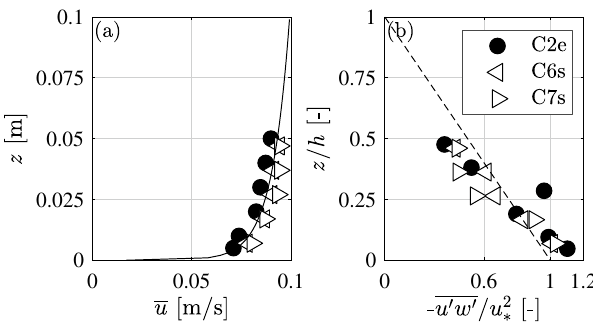
Figure 3. Vertical profiles of ( a ) approach flow velocity (solid line represents logarithmic law, Eq. 2) and ( b ) relative turbulent shear stress (dashed line represents linear profile, Eq.